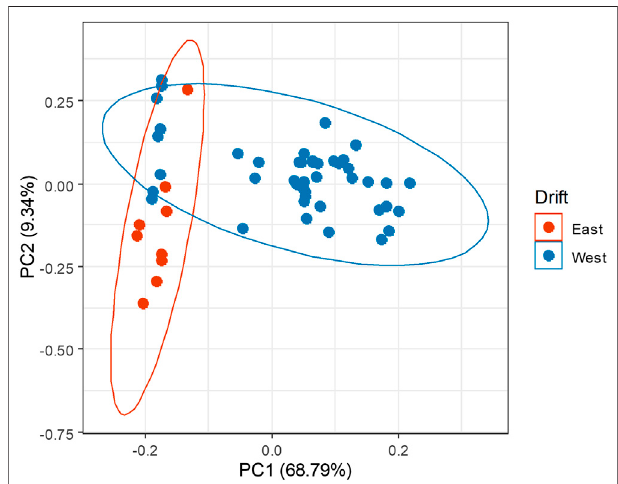
FIGURE 6 | Principal component analysis of Soudan borehole waters based on geochemistry data. PCA was conducted in R using the prcomp() command and plotted using the ggfortify package. After the PCA, the points were plotted with groupings based on the drift in which the boreholes were